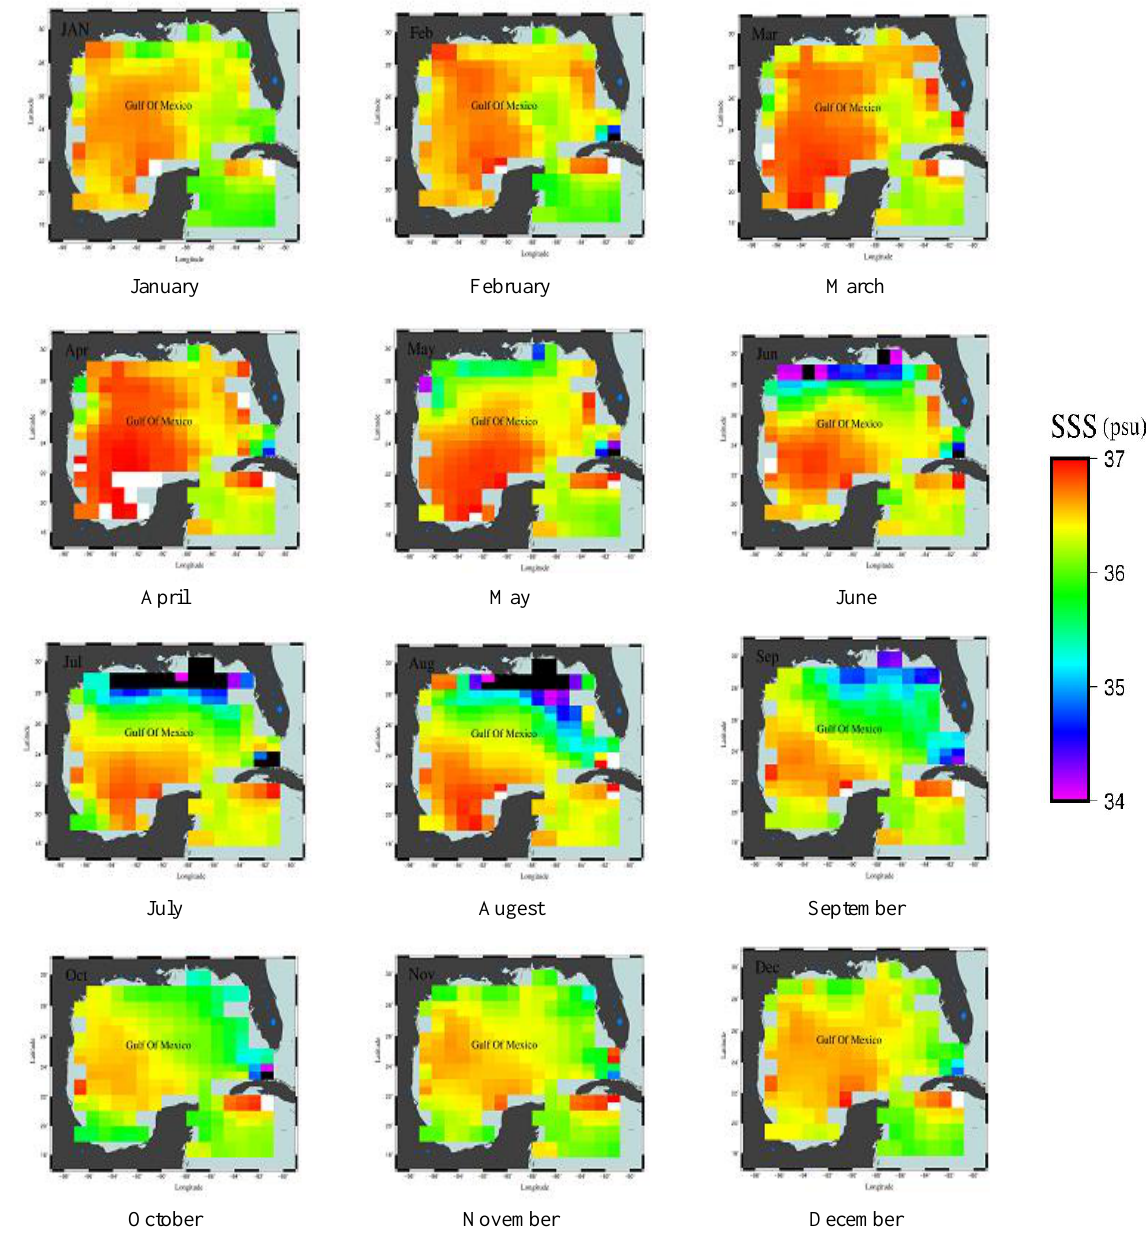
Figure 3. Monthly climatology of the SSS in the Gulf of